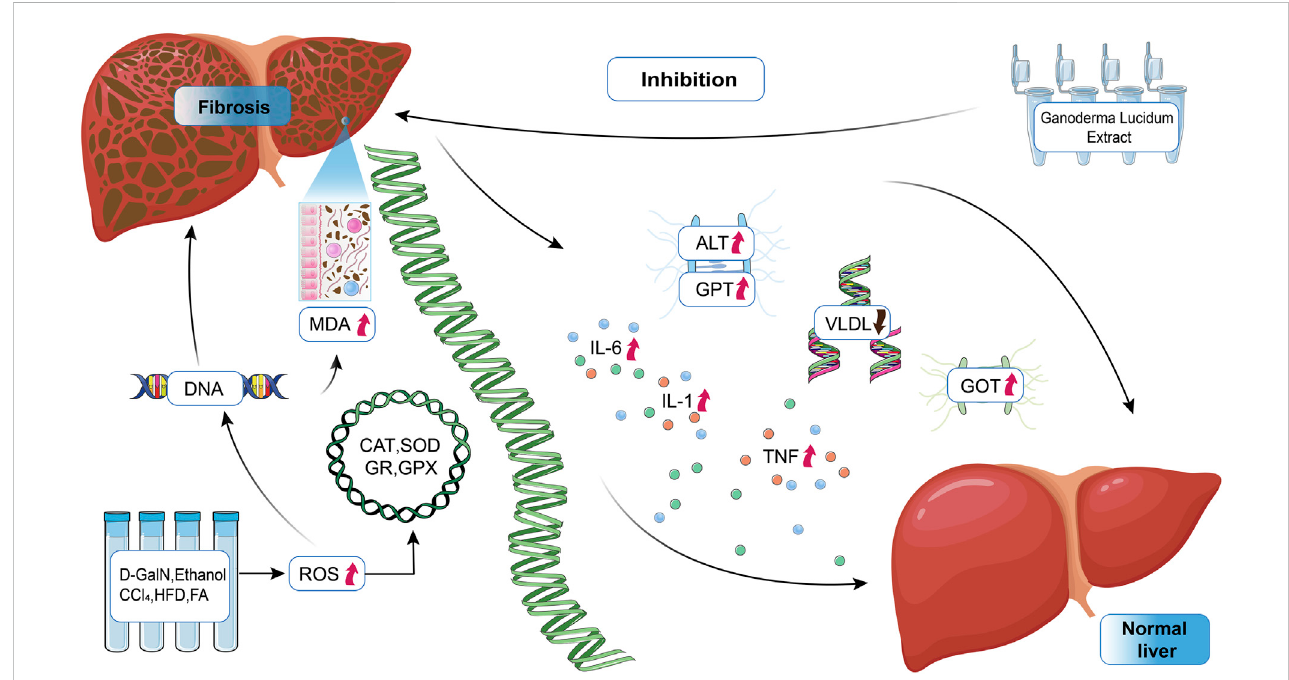
FIGURE 4 Mechanism of action of Ganoderma lucidum in the treatment of liver fi brosis. ALT, alanine aminotransferase; MDA, malondialdehyde; GPT, pyruvate aminotransferase; GOT, glutamate oxaloacetate transaminase; ROS, reactive oxygen species; CAT, catalase; GR, glutathione reductase; GPX, glutathione peroxidase; VLDL, very-low-density